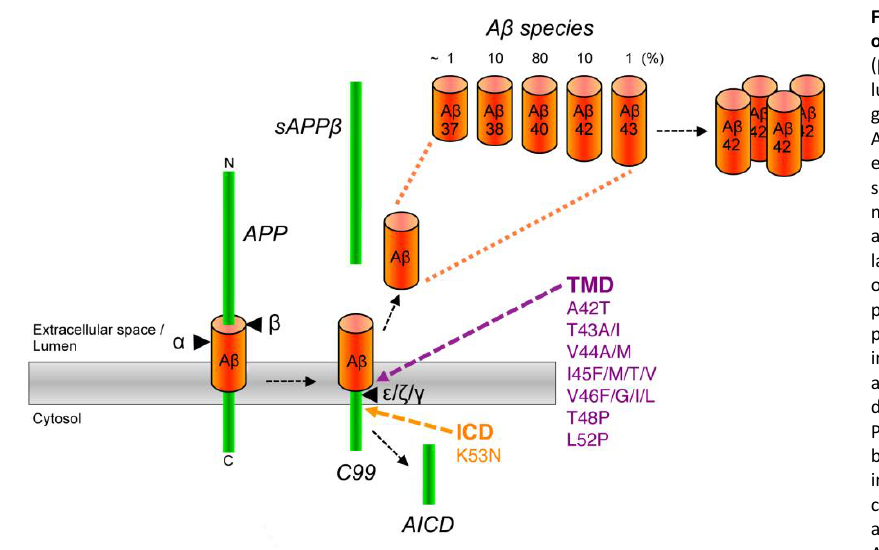
FIGURE 1: APP processing and generation of Aβ. APP is first cleaved by β -secretase (β) in its ectodomain close to the extracel- lular/luminal membrane border thereby generating a 99 amino acid C-terminal APP fragment (C99). Consecutive cleavag- es of C99 by γ - secretase at ε - , ζ - , and γ - sites releases the APP intracellular do- main (AICD) into the cytosol and 37-43 amino acid Aβ species into the extracellu- lar space or lumen of secretory pathway organelles. Longer Aβ forms such as in particular Aβ42 are highly aggregation prone and ultimately deposit as plaques in AD patient brains. An alternative cleav- age of APP by α - secretase (α) in the Aβ domain prevents the formation of Aβ. Pathogenic APP FAD mutations that have been shown or are likely to cause relative increases in the generation of Aβ42 spe- cies are located in the γ -secretase cleav- age region of the APP TMD and in the